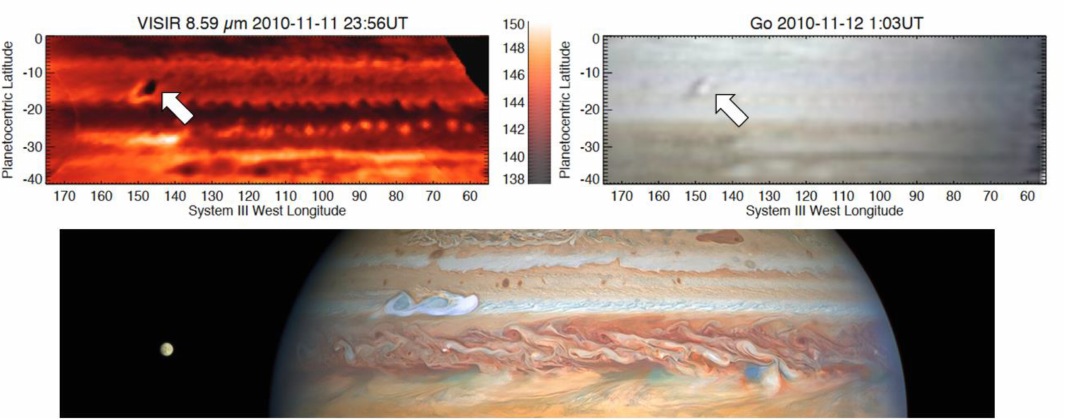
Figure 1. Observations of large − scale outbreaks on Jupiter in the SEB (top panel, from [29]) and the NTB (bottom panel, image credit: NASA/ESA/STScI/A. Simon/M. Wong). Both these outbreaks begin as a single convective plume (bright white cloud) and eventually envelop the belt within the span of a few weeks to